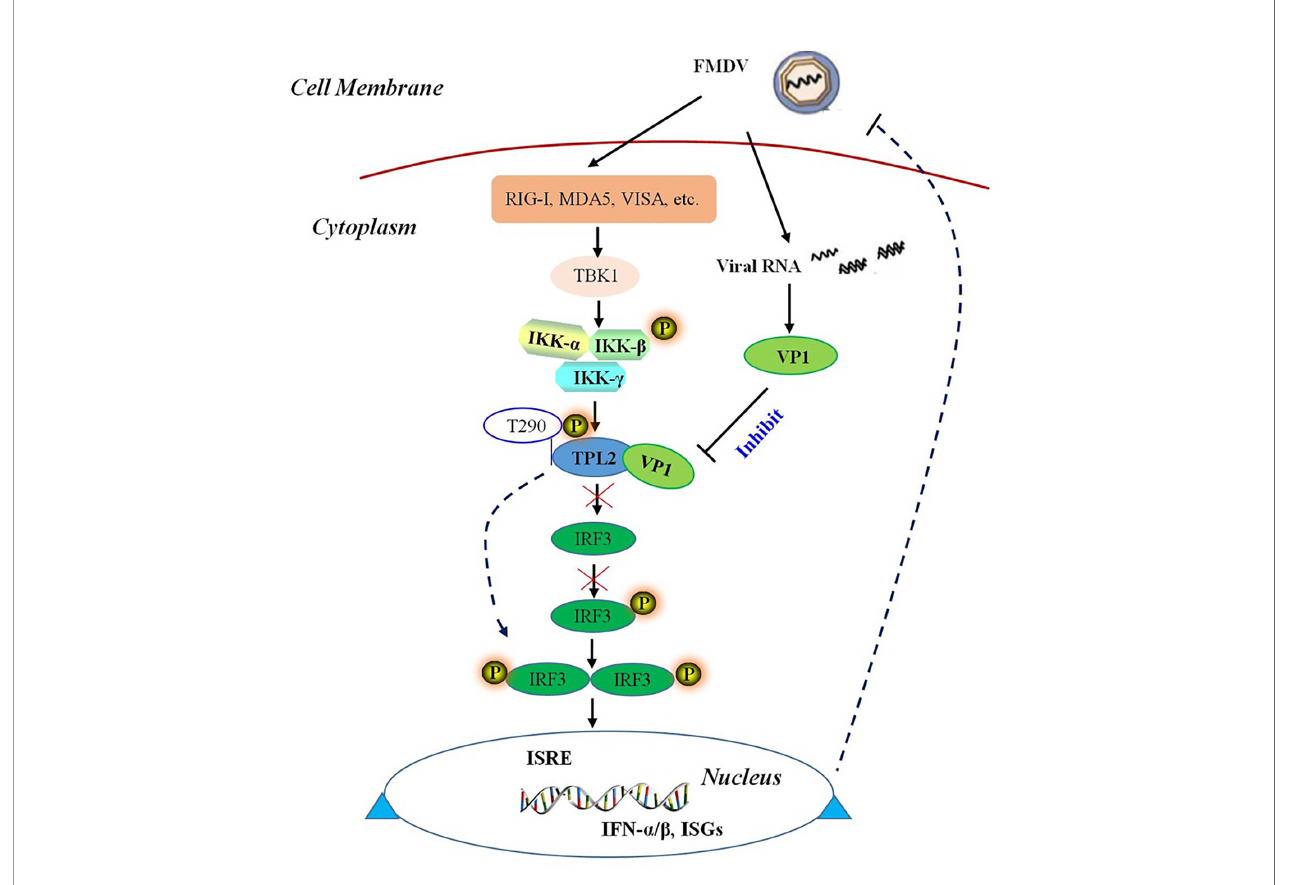
FIGURE 9 | Schematic representation of a model VP1 inhibition of TPL2-mediated IRF3/IFN- b signaling. FMDV VP1 interacts with TPL2 and impairs its phosphorylation at Thr290. IFMDV capsid protein VP1 interacted with host TPL2 and inhibited TPL2-mediated IRF3/IFN- b signal pathway to immune escape and facilitate virus